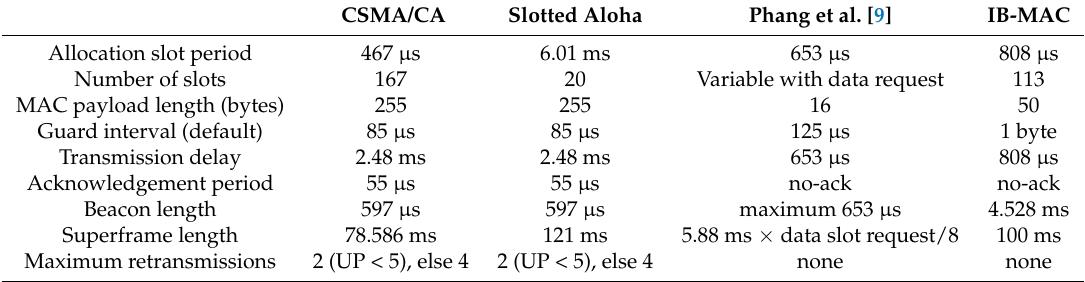
Figure 14. Structure of IEEE 802.15.6 based CSMA/CA and Alotted Aloha frames [2]. Table 2. MAC parameters in 802.15.6 based CSMA/CA, Slotted Aloha, a state-of-the-art IBC MAC protocol [9], and IB-MAC in our simulations. All MAC protocols operate on a 1 Mbps data rate environment.